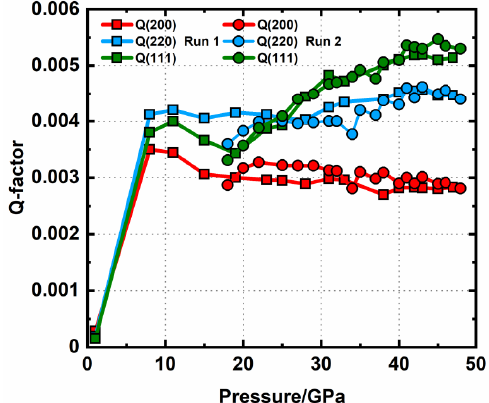
Figure 2. Experimental lattice strains of {200}, {220}, and {111} planes. Rectangles represent data in Run 1; circles represent data in Run 2.